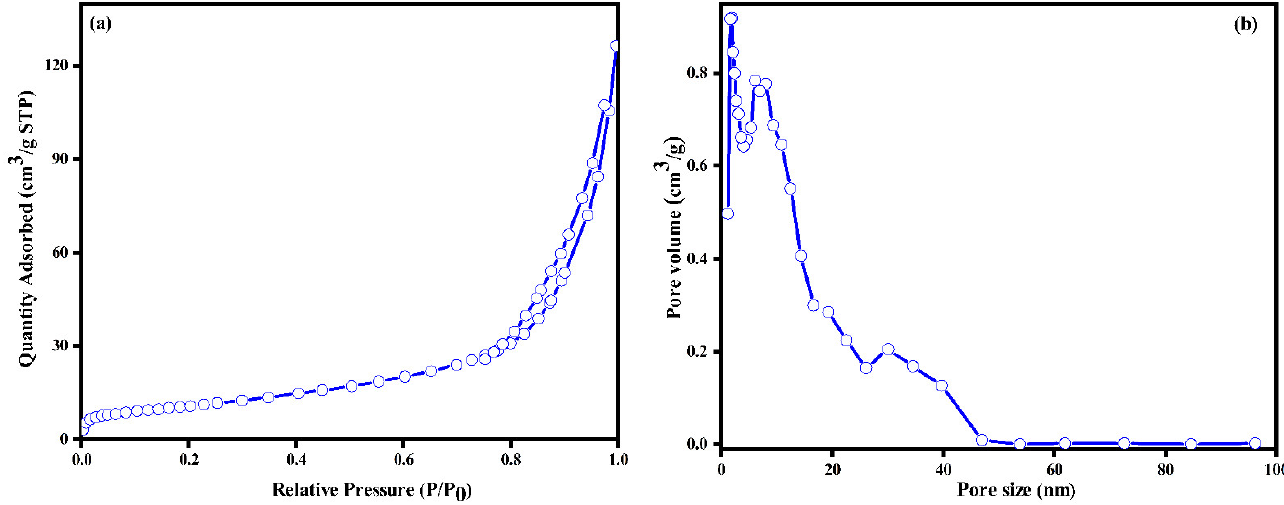
Figure 1. ( a ) Adsorption–desorption isotherm (nitrogen) and ( b ) BJH pore-size distribution of ZSM-5 zeolite.